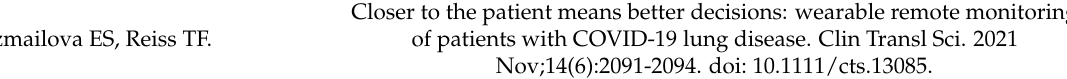
Table A1. List of Selected